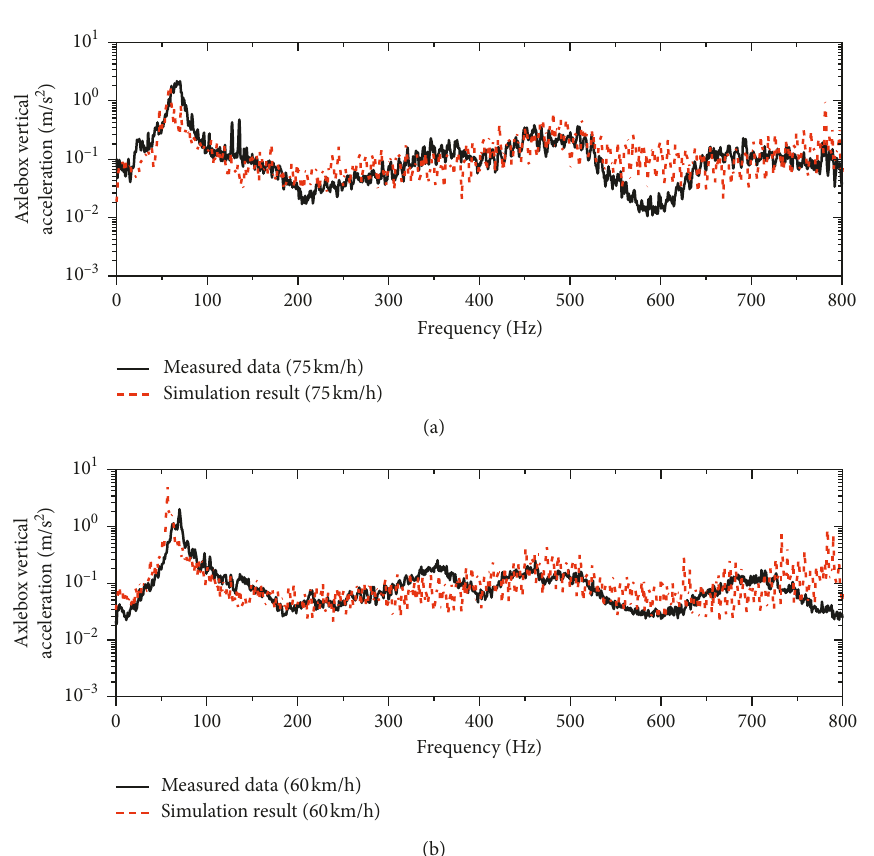
Figure 14: Comparison of the frequency spectra of axlebox vertical accelerations between simulations and